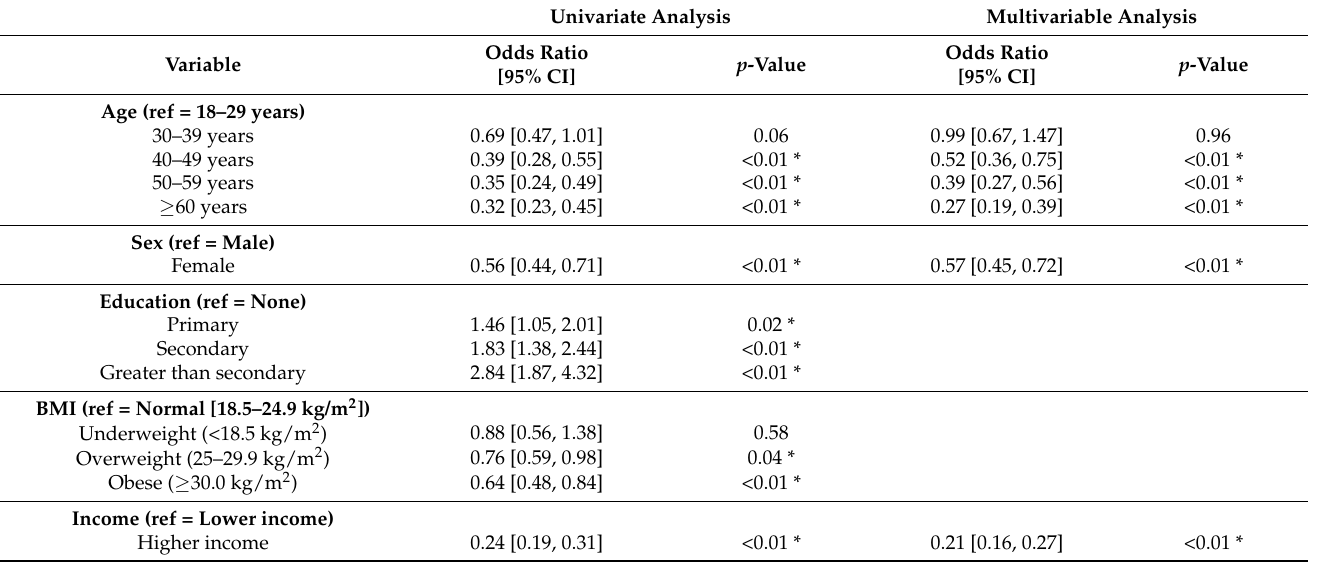
Table 7. Associations between sociodemographic characteristics and high home salt consumption among the study population.